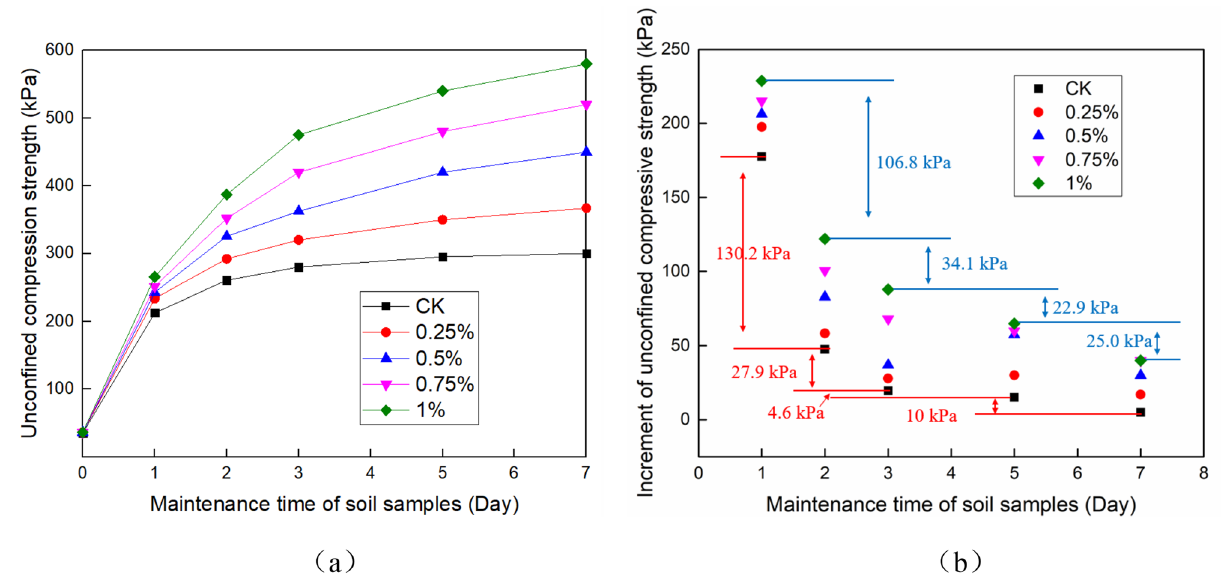
Figure 3. Unconfined compressive strength of the soil under different curing ages. ( a )The strength of the soil, and ( b ) The strength increment of the soil.